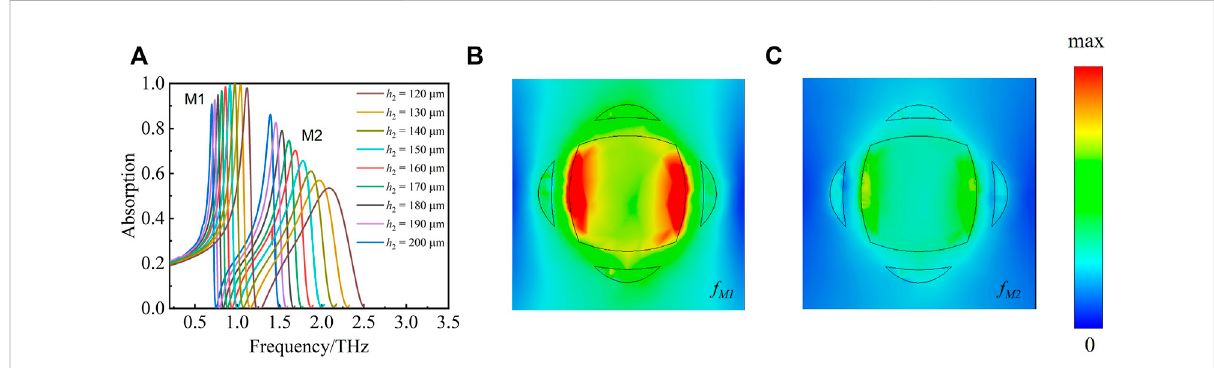
FIGURE 4 (A) The graph of the absorption lines corresponding to h 2 from 120 to 200 µm . Electric fi eld distribution of graphene-based THz metasurface sensor at h 2 (cid:1) 180 μ m resonant frequency: (B) f M1 ; (C) f M2